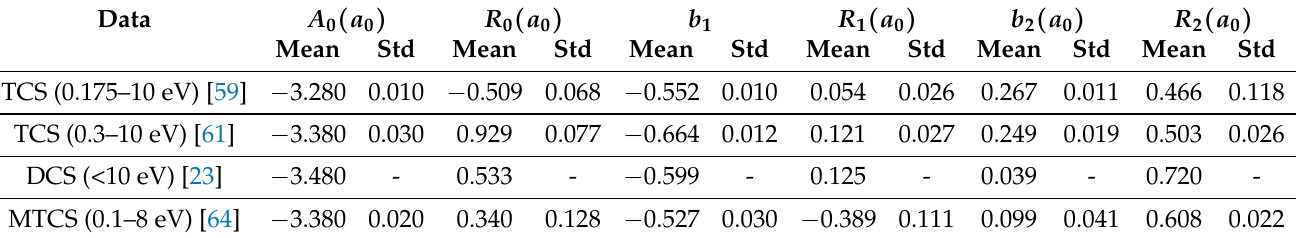
Table 4. Mean values and standard deviations of MERT parameters (appearing in the effective range approximation, Equation (10)) for e − + Kr elastic scattering. The results were calculated using the dipole polarizability α = 16.86 a 3 the effective quadrupole polarizability β = 8.0 a 5 0